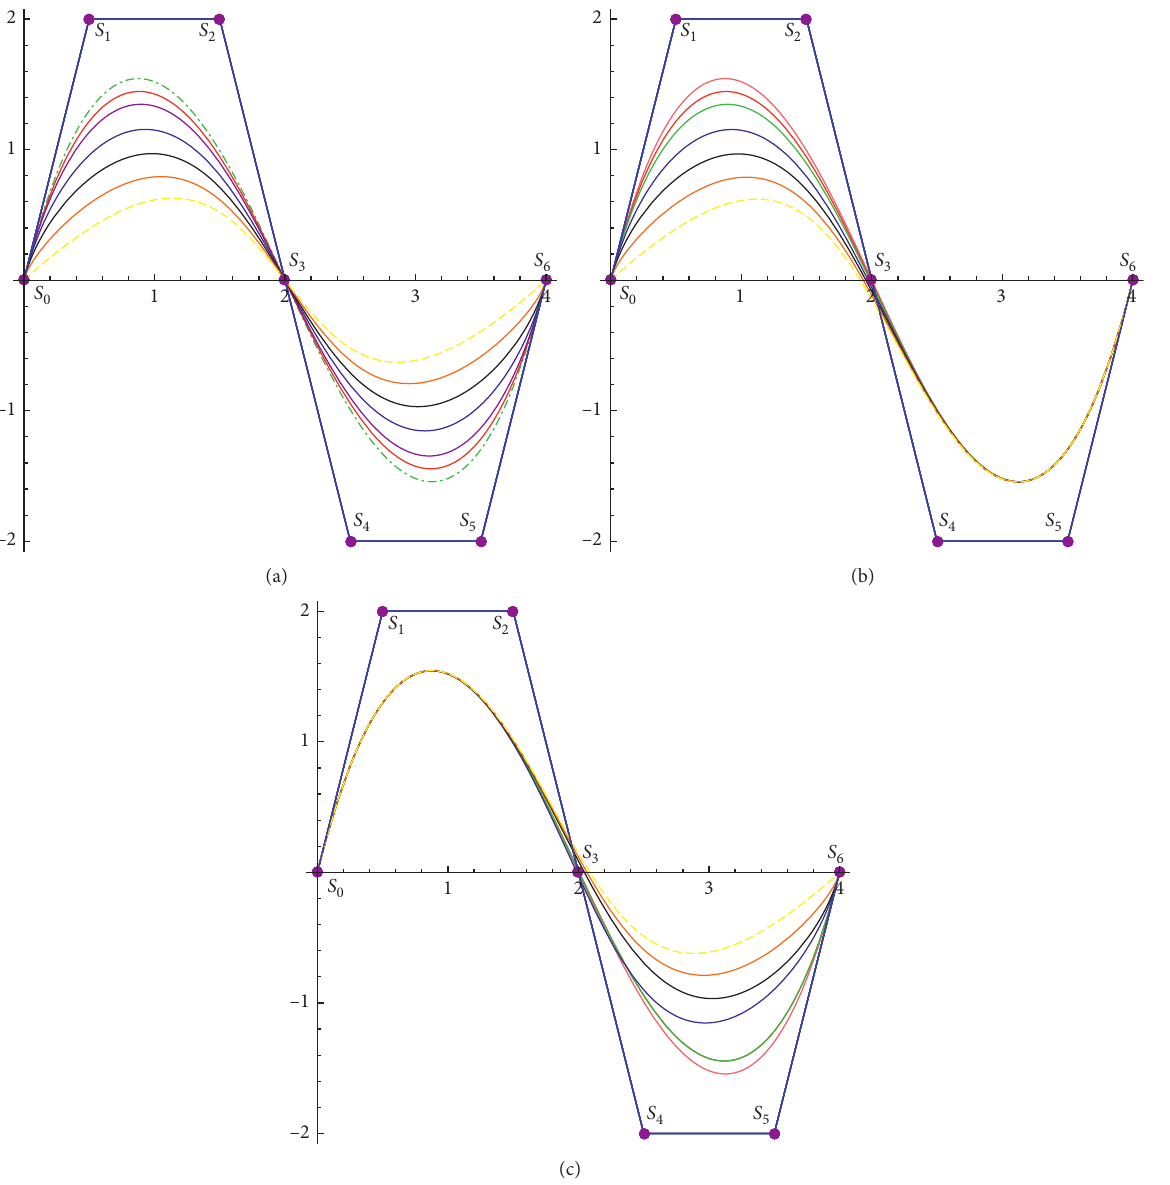
Figure 5: Effect on shape of the curve by changing the shape parameters. (a) ω � μ � 1 , 0 . 5 , 0 , − 1 , − 2 , − 3 , − 4. (b) μ � 1and ω � 1 , 0 . 5 , 0 , − 1 , − 2 , − 3 , − 4. (c) ω � 1 and μ � 1 , 0 . 5 , 0 , − 1 , − 2 , − 3 , −